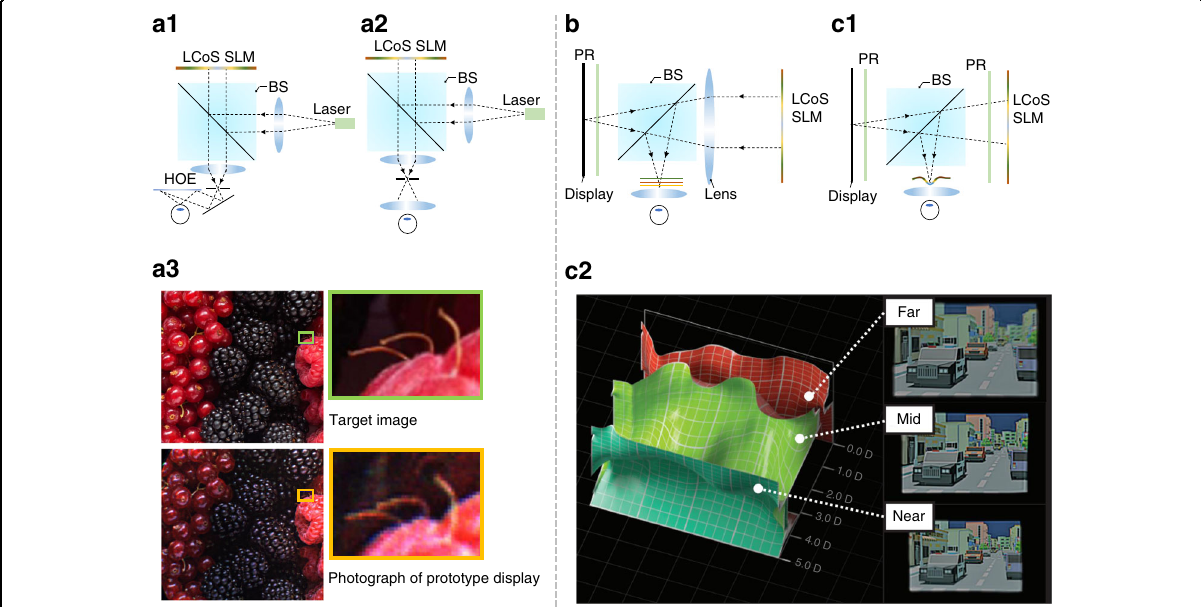
Fig. 7 Phase-only LCoS for AR/VR systems. a1 Schematic of phase LCoS based AR system. a2 Schematic of phase LCoS based VR system. a3 Image quality comparison between the target and the photography of the prototype. b 4 f system with a LCoS SLM. c1 Focal surface system con fi guration with a LCoS SLM. c2 The optimized focal surfaces and color images displayed across three frames. Adapted from a3 ref. 92 . and c2 ref. 137 . under